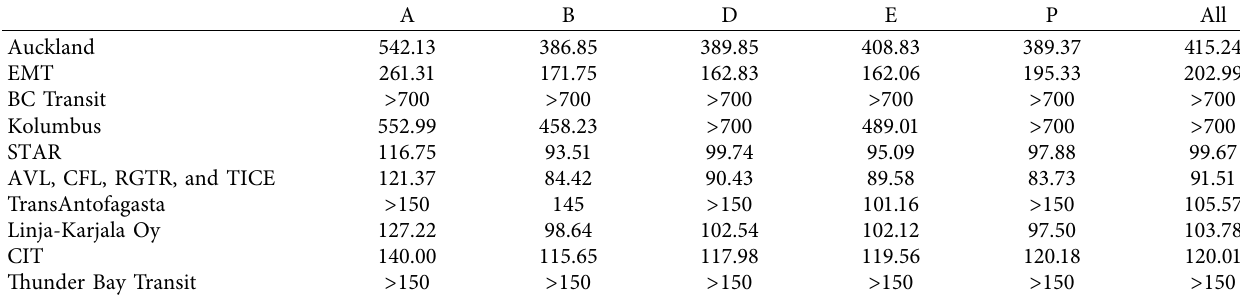
Table 17: For pI � 0.05 and pR � 0.0025, average propagation time in which IR reached 60% in each group (A, B, D, E, P) and globally.